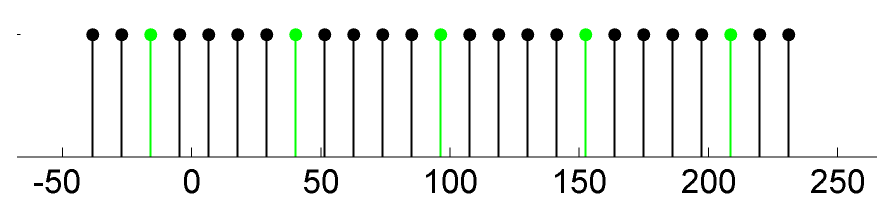
Figure 5. Elevation aperture positions